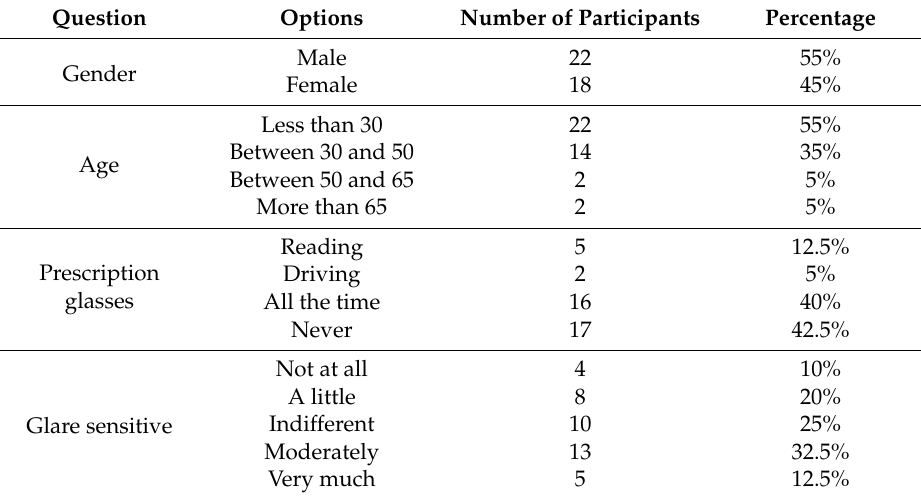
Table 1. Demographic data of participants.